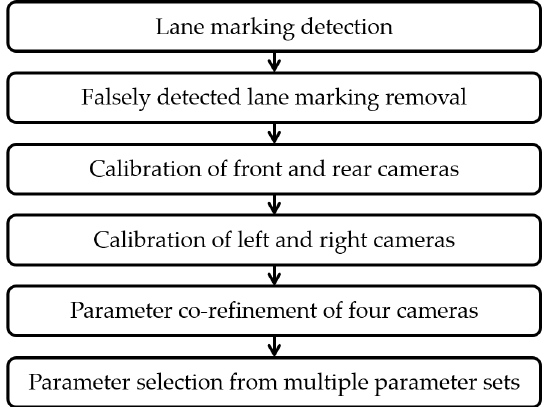
Figure 3. Flowchart of the proposed method.